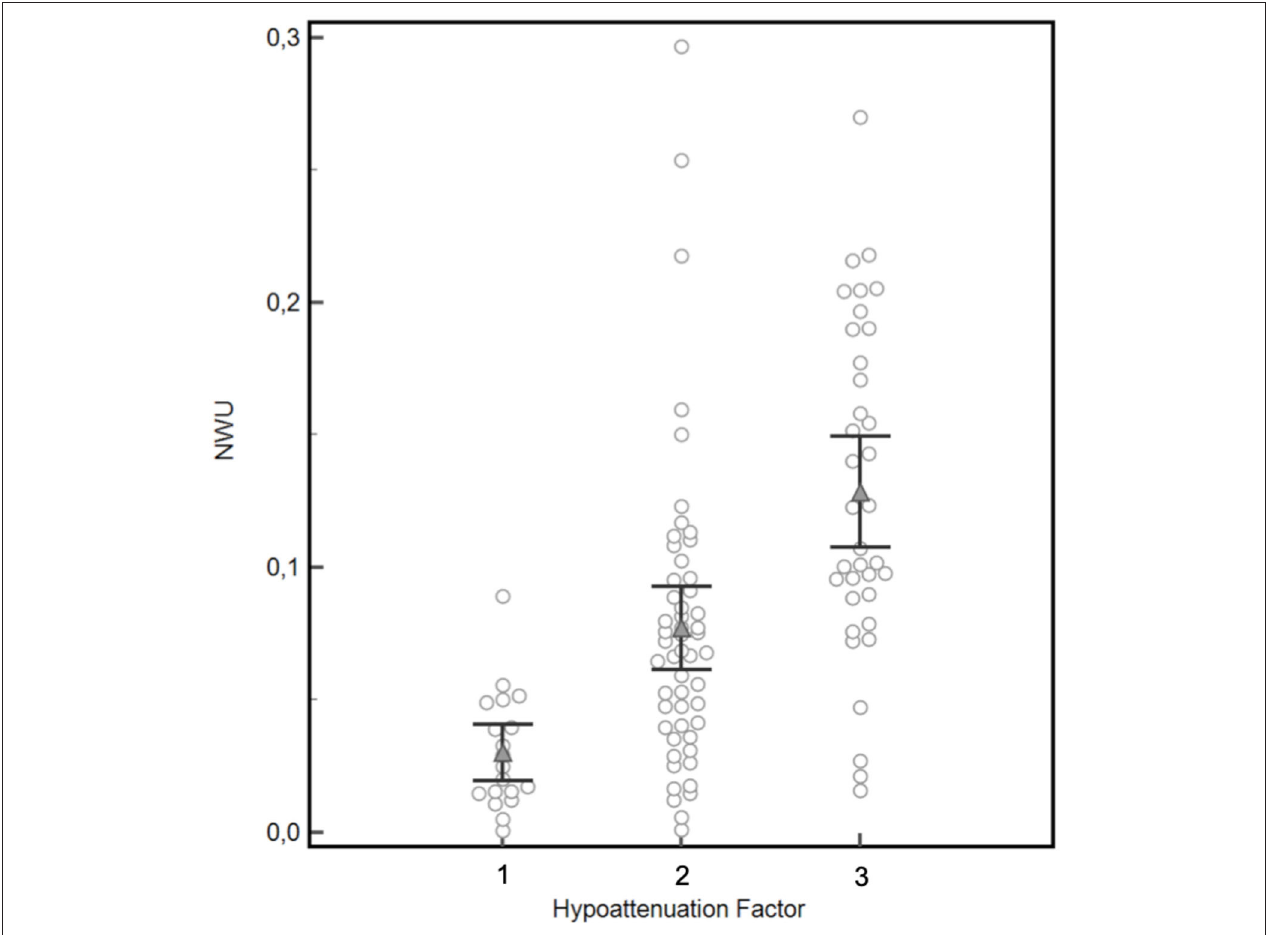
FIGURE 2 | Validation of the visually rated hypoattenuation factor by semi-automatic quantification of net water uptake (NWU). Mean NWU differed significantly between the three patients groups classified for hypoattenuation factor 1 (mean NWU 3.0%), 2 (mean NWU 7.7%), and 3 (mean NWU 12.9%), black brackets indicate 95%CI, p = 0.0001 for factor 1 vs. factor 2, p < 0.0001 for factor 2 vs. factor